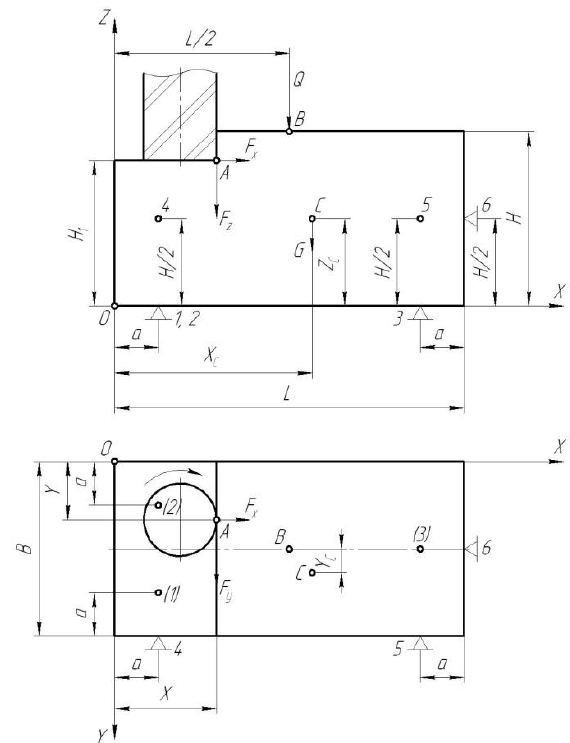
Figure 1. Calculation scheme of the mechanical system “fixture –